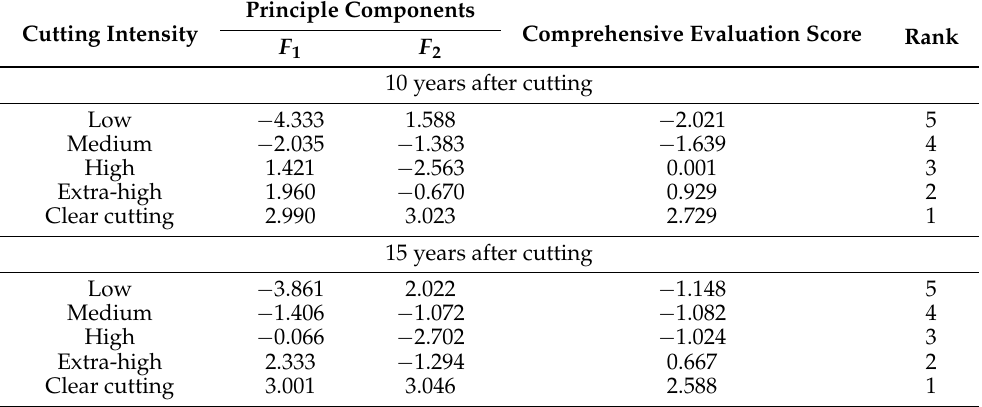
Table 11. Aggregate impacts of cutting intensity on overall soil physical and chemical properties.